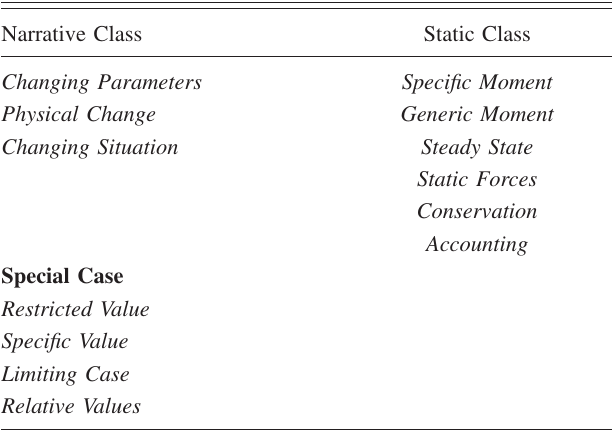
quantities in the equation (cid:1) e.g., does v correspond to voltage, or velocity? Does r correspond to the radius of the circle, or